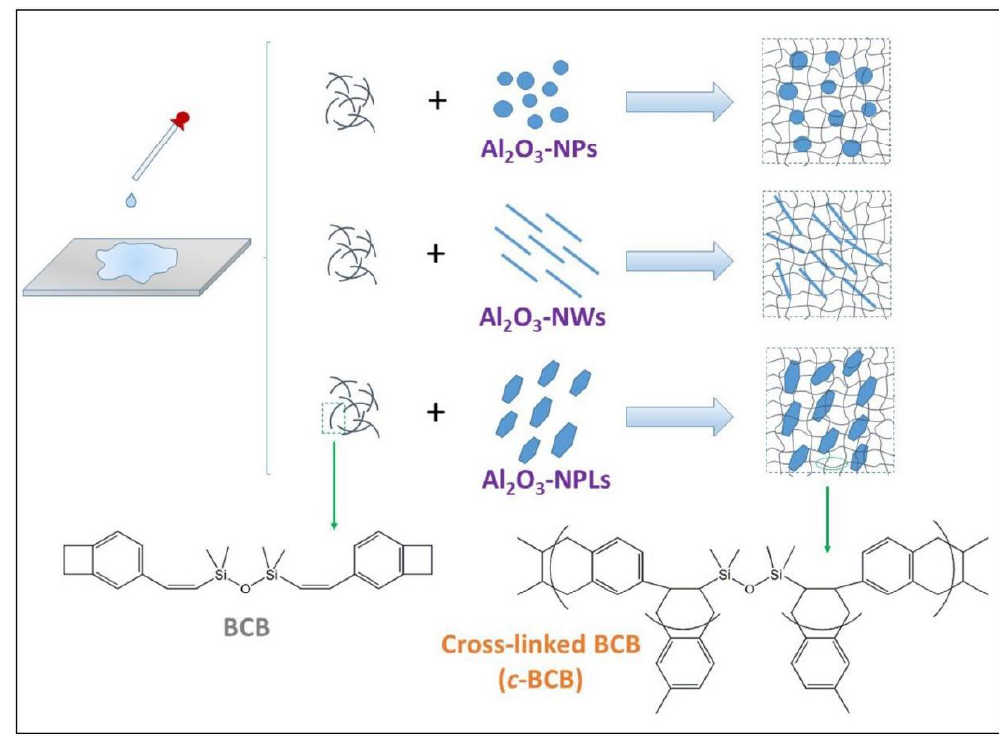
Figure 11. Schematic of the preparation of c -BCB/Al 2 O 3 -NPs, -NWs and -NPLs nanocomposites. Reproduced with permission from Ref. [84]. Copyright 2019, Wiley – VCH.